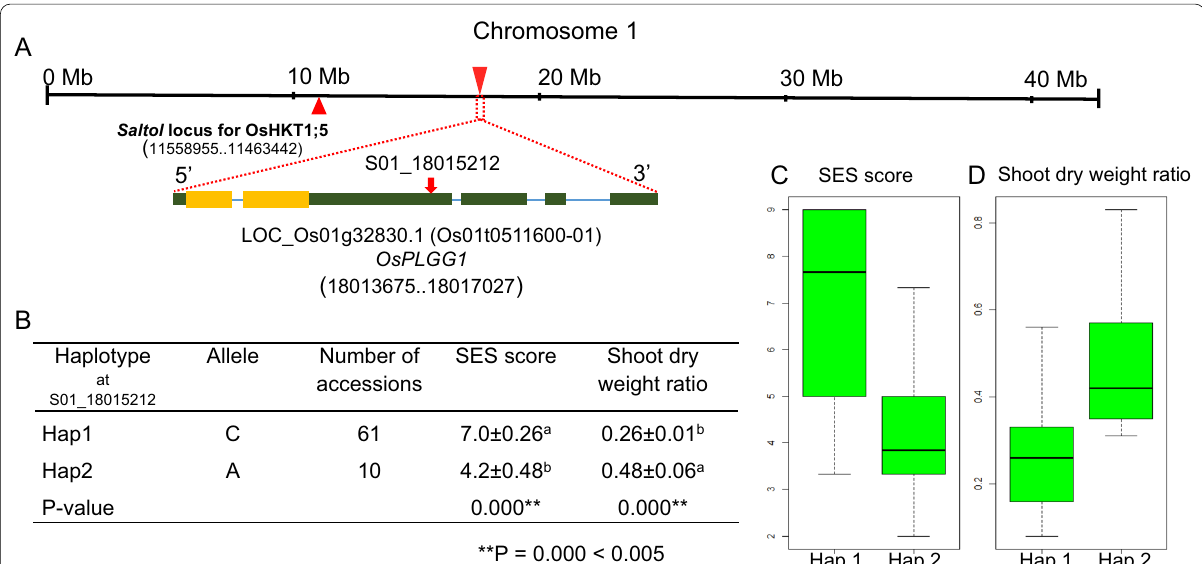
Fig. 6 Location of the SNP peak on chromosome 1 and haplotype analysis. A Schematic representation of rice chromosome 1 and the position of SNP S01_18015212 within the 3 ′ UTR of LOC_Os01g3283 ( OsPLGG1 ). This gene is 6.5 Mb away from the Saltol locus. According to RAP-DP, translated and untranslated regions in LOC_Os01g3283 were indicated by orange and green rectangles, respectively. ORF B S01_18015212 defines two haplotypes among 71 accessions: Hap 1 was found in 61 accessions with nucleotide C, and Hap 2 was found in 10 accessions with A . The remaining eight accessions had no exact haplotype (heterozygous alleles). C , D Significant differences in SES scores ( C ) and shoot dry weight ratio ( D ) values between Hap 1 and Hap 2